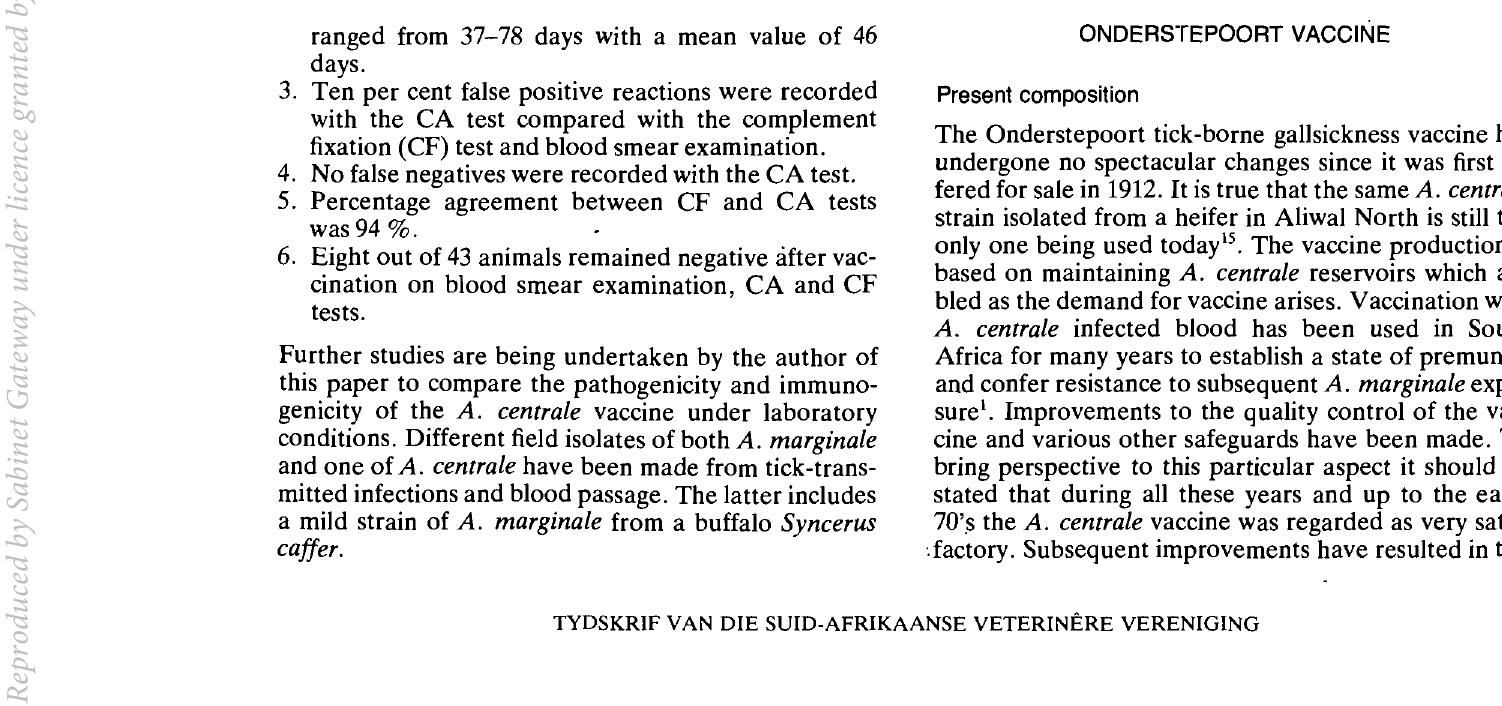
Table 3: REACTIONS TO THE ONDERSTEPOORT A. CENTRALE VACCINE 2 me GIVEN SUBCUTANEOUSLY (BARROWMAN & FERREIRA, UNPUBLISHED DATA, 1977178)